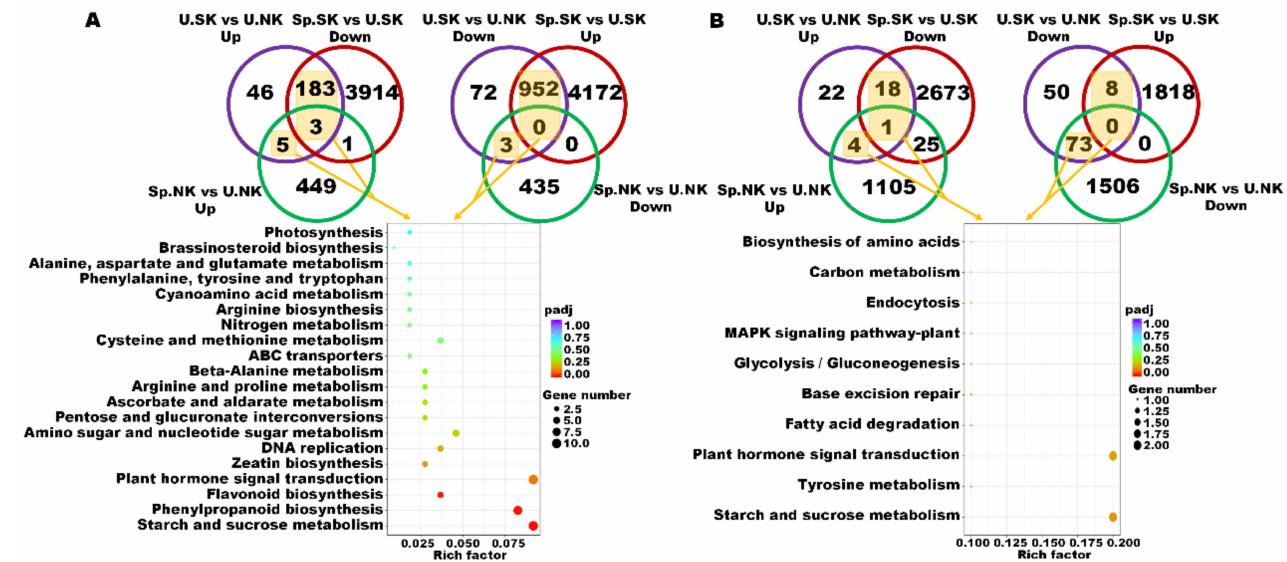
Figure 7. KEGG pathway enrichment analyses of the two tea plant genotypes in response to hetero- geneous vs. homogeneous K environments. KEGG pathway enrichment analyses in genotype “1511” to acclimate to heterogeneous K supply ( A ). KEGG pathway enrichment analyses in genotype “1601” to acclimate to heterogeneous K supply. The key genes for KEGG pathway enrichment analyses were circled in the Venn diagrams ( B ).